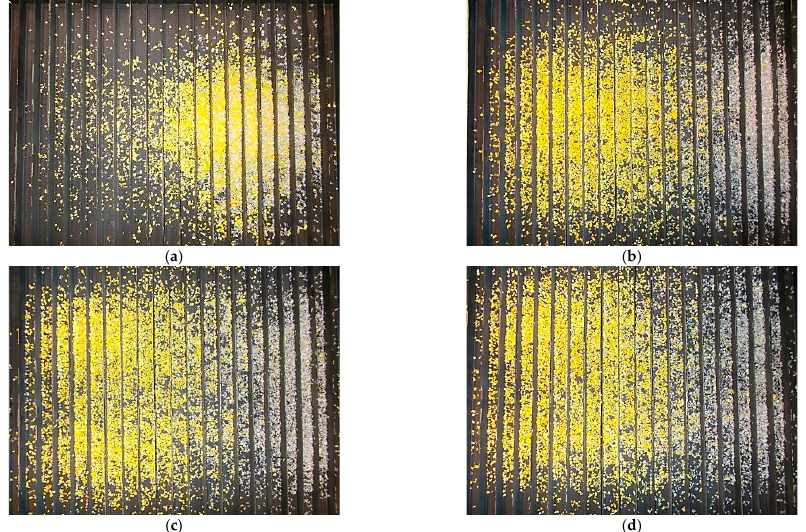
Figure 14. The separation result of ( a ) without charging and after tribocharging for t = 60 s in a container with ( b ) PET-G, ( c ) ASA, ( d ) PP at an airflow of 2.19 cpm. As can be observed, the developed vision system allows one, among others, to es- timate quite precisely the percentage of one material over another in each box of a col- lector, i.e., to illustrate the dominance of one material over another (Figure 15—Sec. II). The results seem quite similar. However, the assessment of the content of a given poly- mer in each box (Figure 15—Sec.III) indicates that the most well-separated particles of both polymers were obtained when using a PP container for tribocharging. In this case, most particles of both materials were separated in extremely distant boxes. It means that during the tribocharging process in this container, more PET particles obtained a large negative charge and deviated towards the positive electrode. A high number of PE-HD particles obtained a large positive charge and deviated towards the negative electrode (remaining with the separator roller connected to the ground).